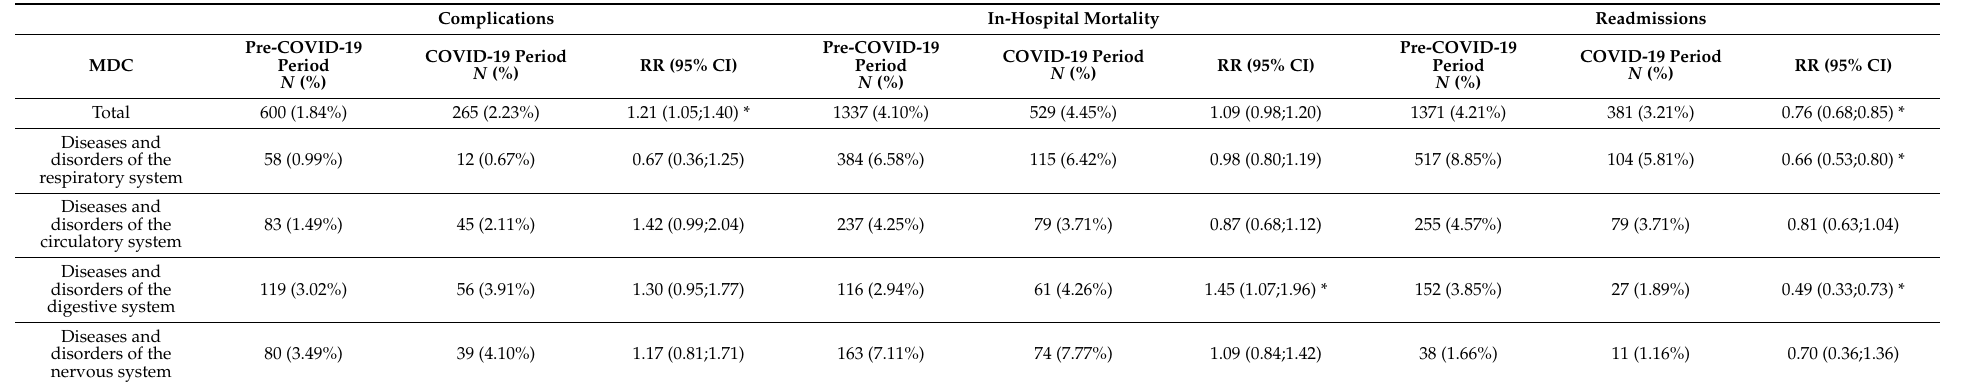
Table 3. Comparison of complications, mortality, and readmissions between pre-COVID and COVID period by Major Diagnostic Categories (MDC). CI: